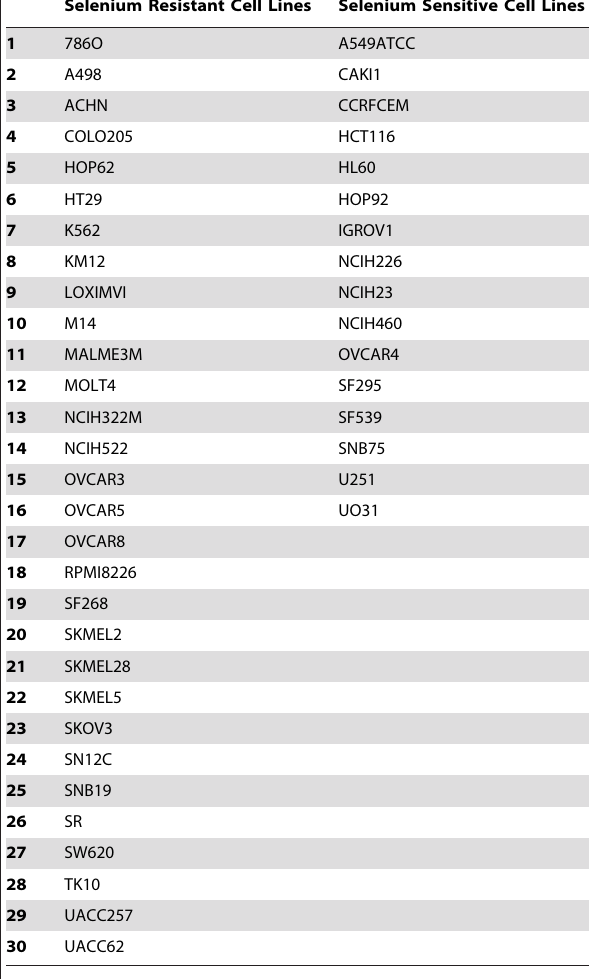
Selenium Resistant Cell